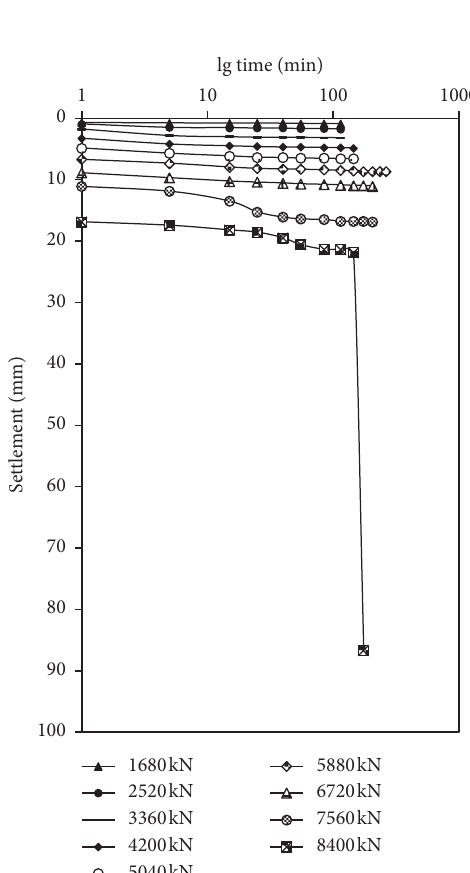
Figure 22: s-lgt curve of